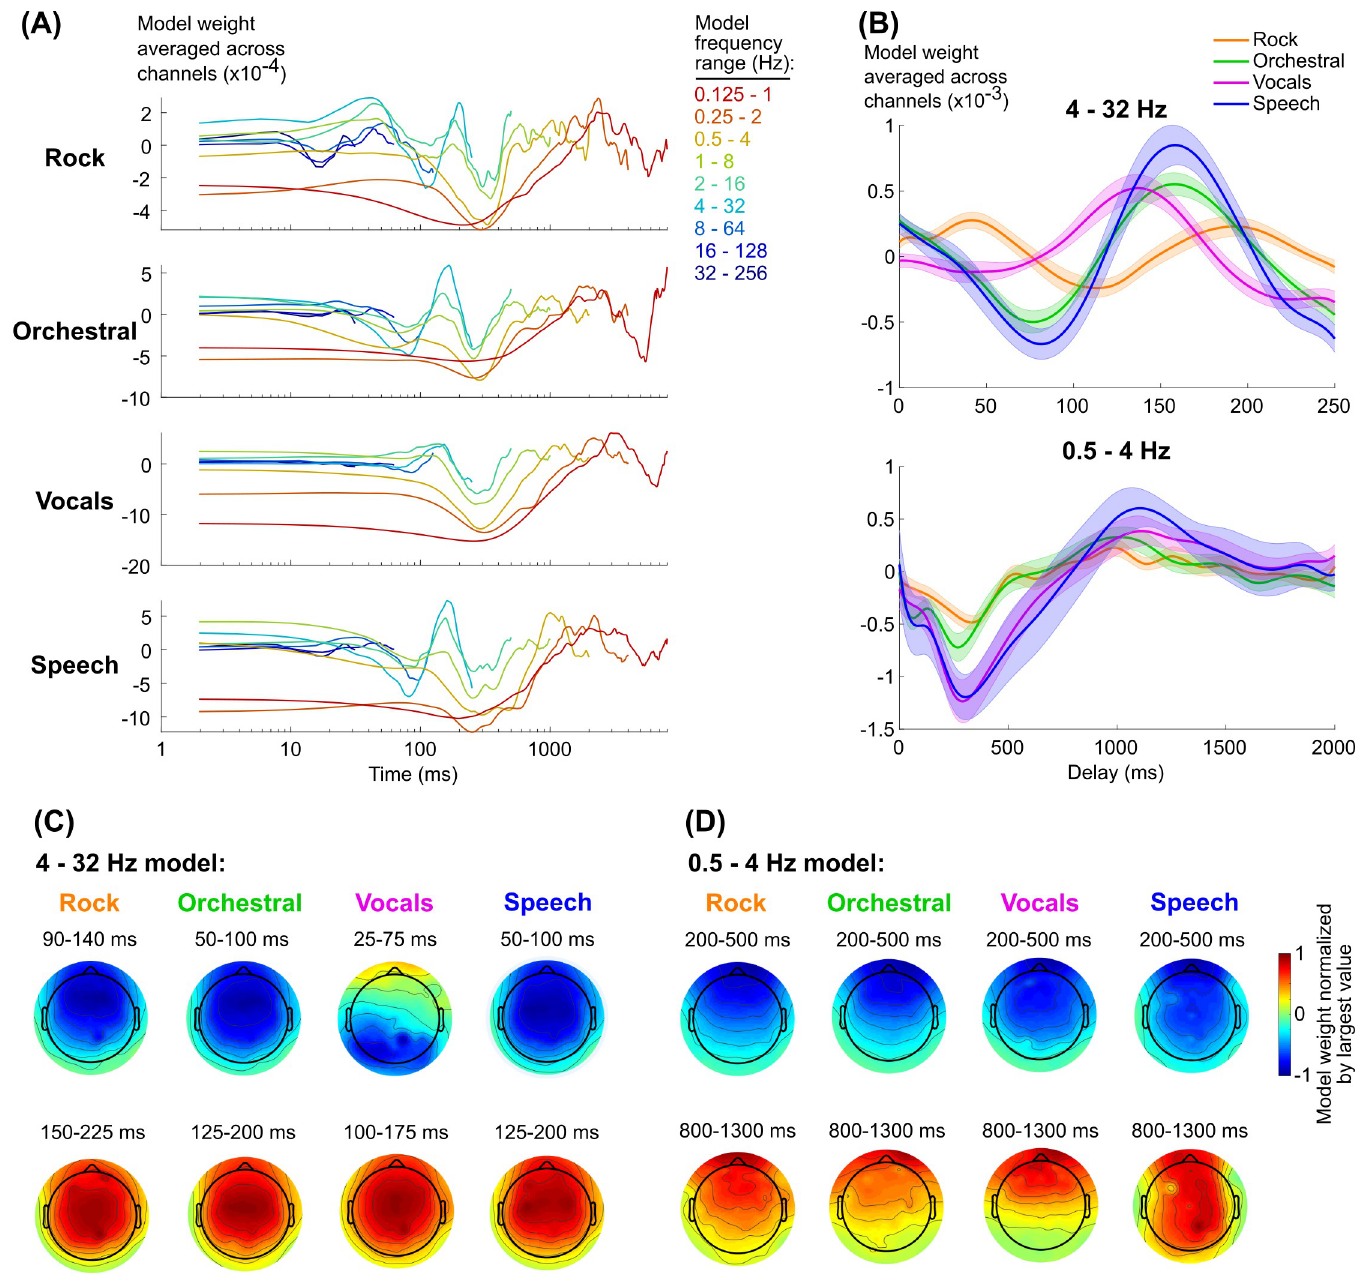
Fig 4. (A) Model weights, median across subjects and averaged across channels. Models are color-coded based on their frequency range (see to the right of the plots). The model of the range 0.0625–0.5 Hz was excluded because none of the stimuli exhibited significant neural tracking in this range, and the large values for the weights obscured the trends in the other models. (B) Mean and standard error across subjects of model weights for two frequency ranges (see S9 Fig for the models for individual subjects). (C) and (D) show the topographies of the model weights averaged over the range of delays corresponding to peaks and troughs in the 4–32 Hz and 0.5–4 Hz models respectively. Note that the range of delays vary across stimulus types in the 4–32 Hz model in order to capture similar peaks and